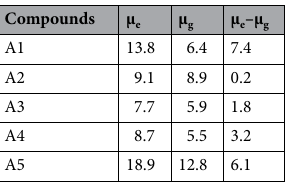
Table 2. The ground state ( µ g ) and excited state dipole moments ( µ e ) of A1 – A5 in gas phase.